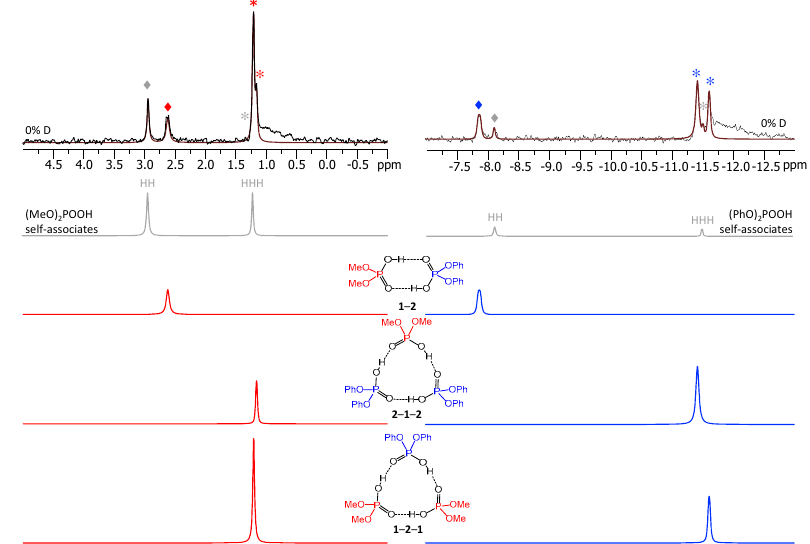
Figure 4. The parts of 31 P - NMR spectrum of the sample containing acids 1 and 2 (1:1) in CDF 3 / CDF 2 Cl at 100 K. The experimental spectrum is deconvoluted into the sub-spectra arising from self-associated of 1 or 2 , heterodimer 1 - 2, and two heterotrimers, 1 - 2 - 1 and 2 - 1 - 2 . For visual clarify the signals in the experimental spectrum and the computed sub-spectra are color coded. Trimers and dimers are marked by asterisks and diamonds, respectively. Table 1. The 1 H-NMR chemical shifts of bridging proton in various isotopologs of homodimers and heterodimers of POOH-containing acids 1 – 4 in CDF 3 / CDF 2 Cl at 100 K. The corresponding spectra